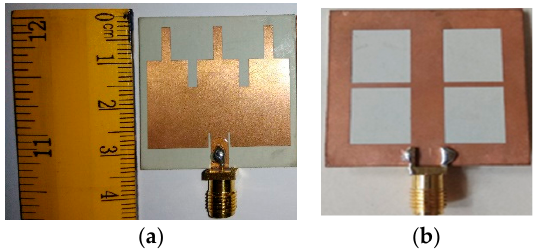
Figure 13. A fabricated prototype of the proposed antenna ( a ) The front side; ( b ) The back side.